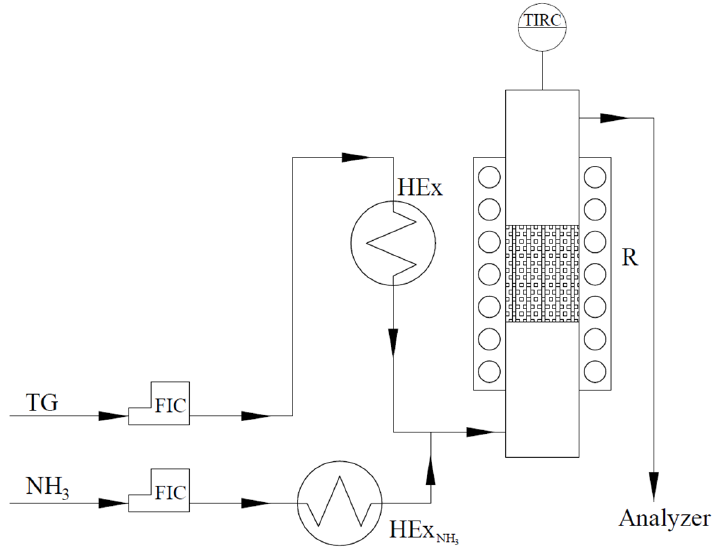
Figure 12. The scheme of the laboratory installation for NH 3 -SCR catalytic tests.